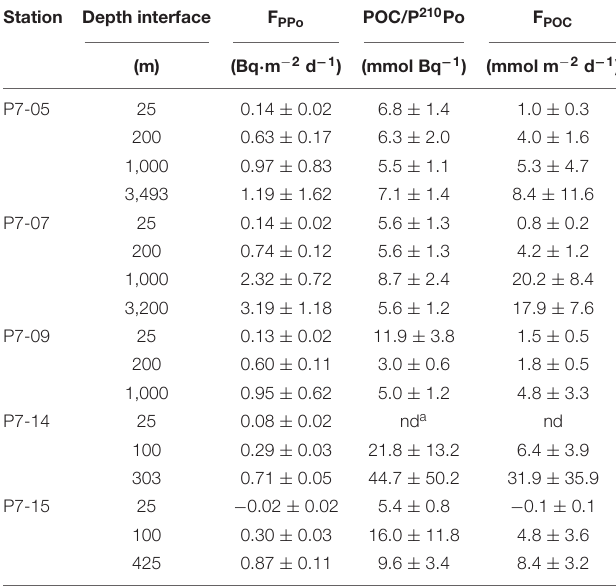
TABLE 2 | POC export flux at different depth interfaces estimated from 210 Po/ 210 Pb disequilibria. Station Depth